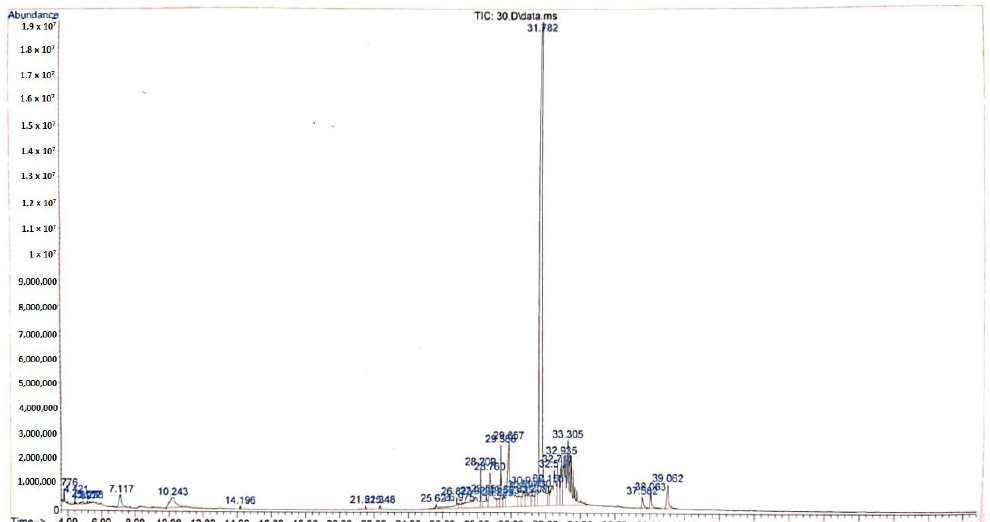
Figure 2. Chromatogram of Tacca tuber ethanolic extract.